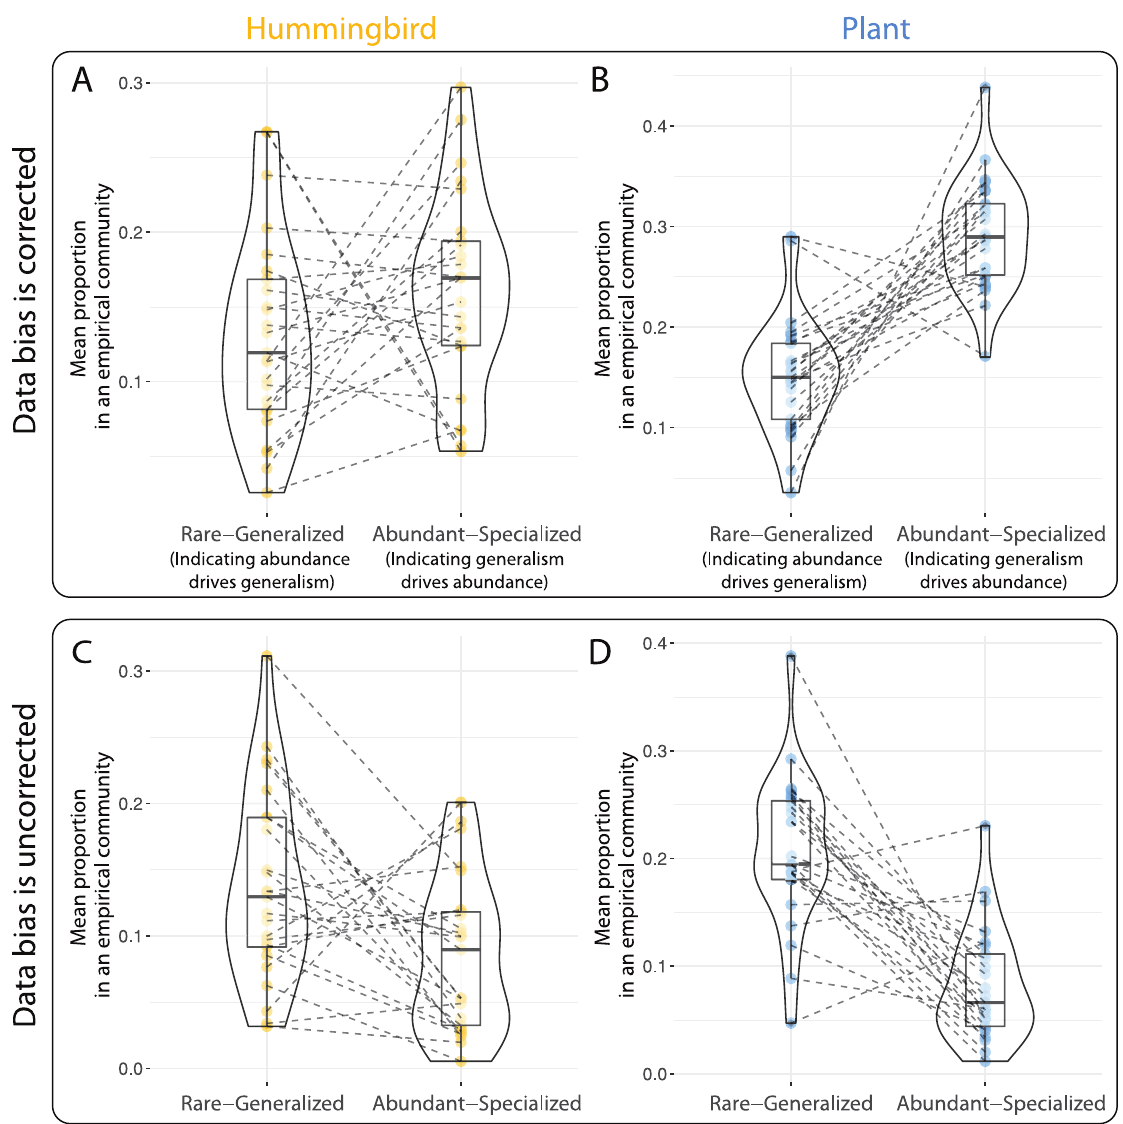
Fig 3. Generalism drives abundance. We apply the causal discovery method based on formal logic to detect the causal direction in an empirical dataset of 25 hummingbird-plant communities. In each panel, the x axis shows the two categories (rare and generalized species versus abundant and species species), and the y axis shows the mean proportion of species in that category. Each point denotes a different empirical community. Each line connects two points in the same empirical community. If the line is going up (meaning there are more species being abundant and specialized), it indicates that generalism drives abundance, and vice versa. The original method (panels C and D ) suggests that generalism drives abundance in most communities (this is expected because the marginal distribution of abundance is more skewed than that of generalism). In contrast, our refined method has removed the bias regarding skewed marginal distributions, and it (panels A and B ) suggests that generalism drives abundance in most communities. The qualitative patterns are similar among hummingbirds (panel A ) and plants (panel B